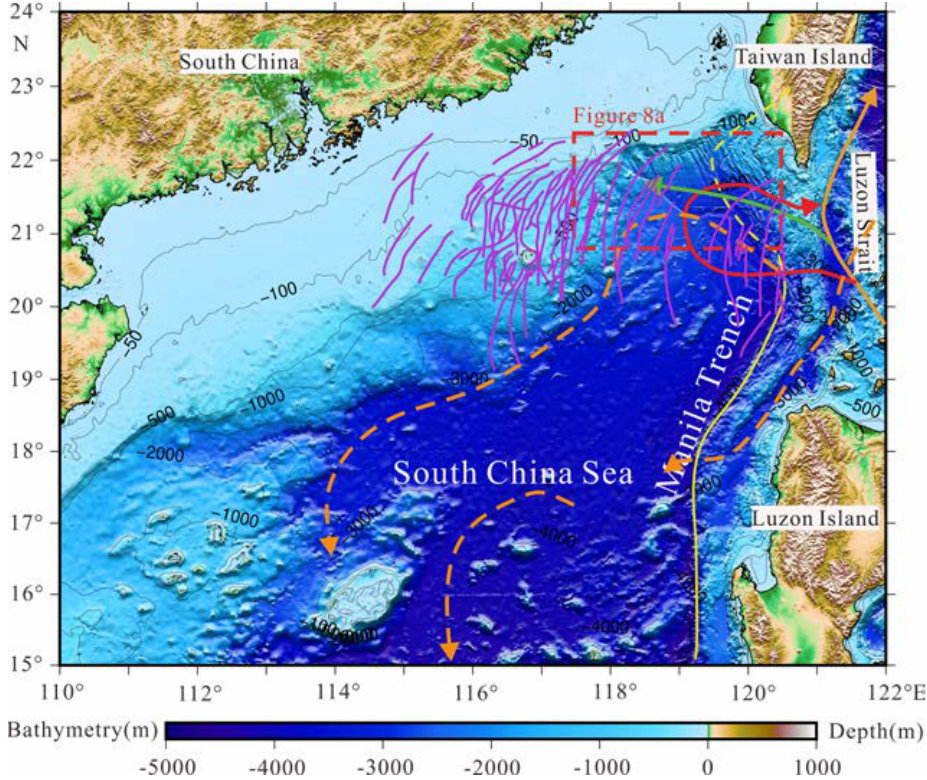
Figure 1. Bathymetric topography of a group of canyons on the northern continental margin of the South China Sea. Red dashed lines represent the Taixinan canyon group. The solid orange line is the direction of Kuroshio movement. The solid red line is the direction of deep-water intrusion movement in the western Pacific. The solid green line is the direction of internal wave movement [24]. The orange dashed line is the deep-water current of the South China Sea [20–23]. The purple curve is the internal solitary wave observed in the satellite image [22].